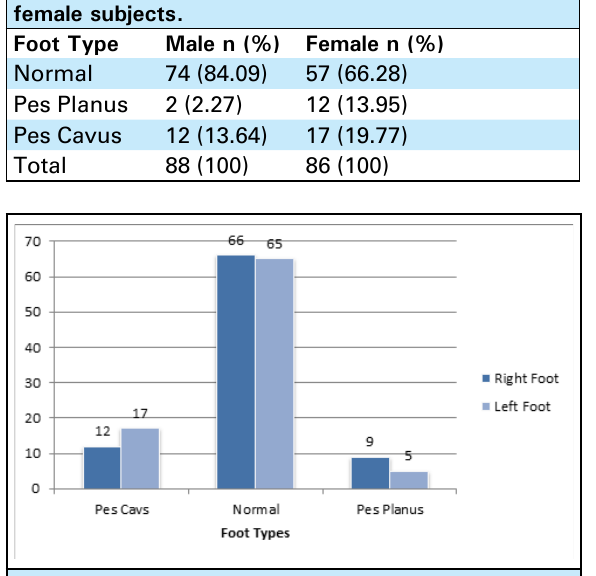
Figure 3. Frequency of different foot types on right and left